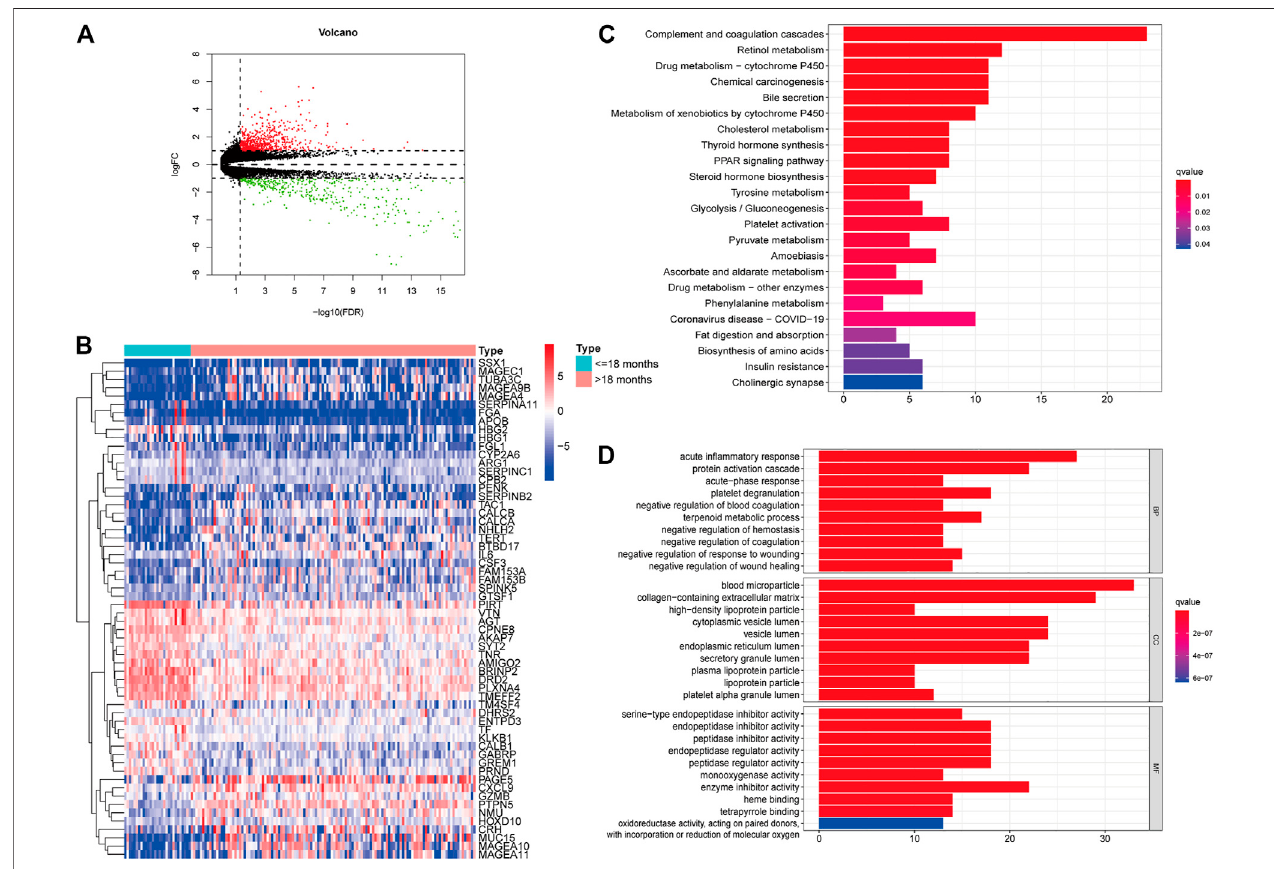
FIGURE 2 | Identi fi cation of differently expressed genes (DEGs) in different age groups. Volcano plot of the DEGs in the TARGET (A) . Heatmap of the DEGs in the TARGET (B) . GO (C) and KEGG enrichment analysis (D) for 204 DEGs in the TARGET cohort, terms with p- and q-value < 0.05 were considered signi fi cant.